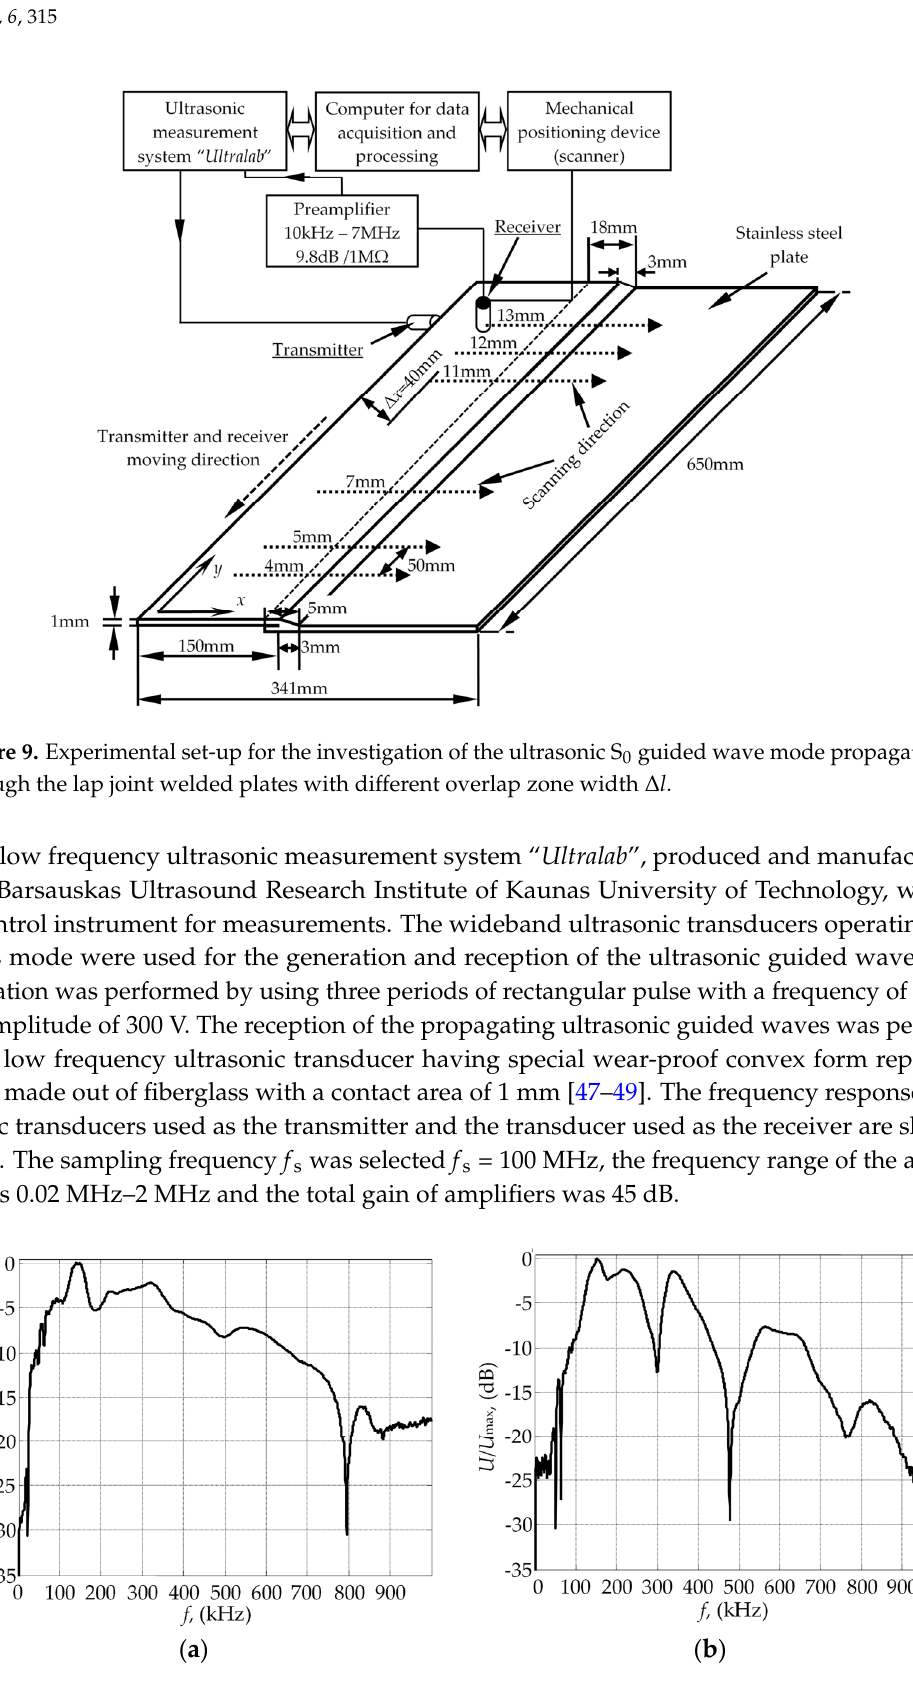
Figure 10. The frequency responses of the ( a ) transmitter and ( b ) receiver with convex protector (the equivalent diameter of the contact area 1 mm).